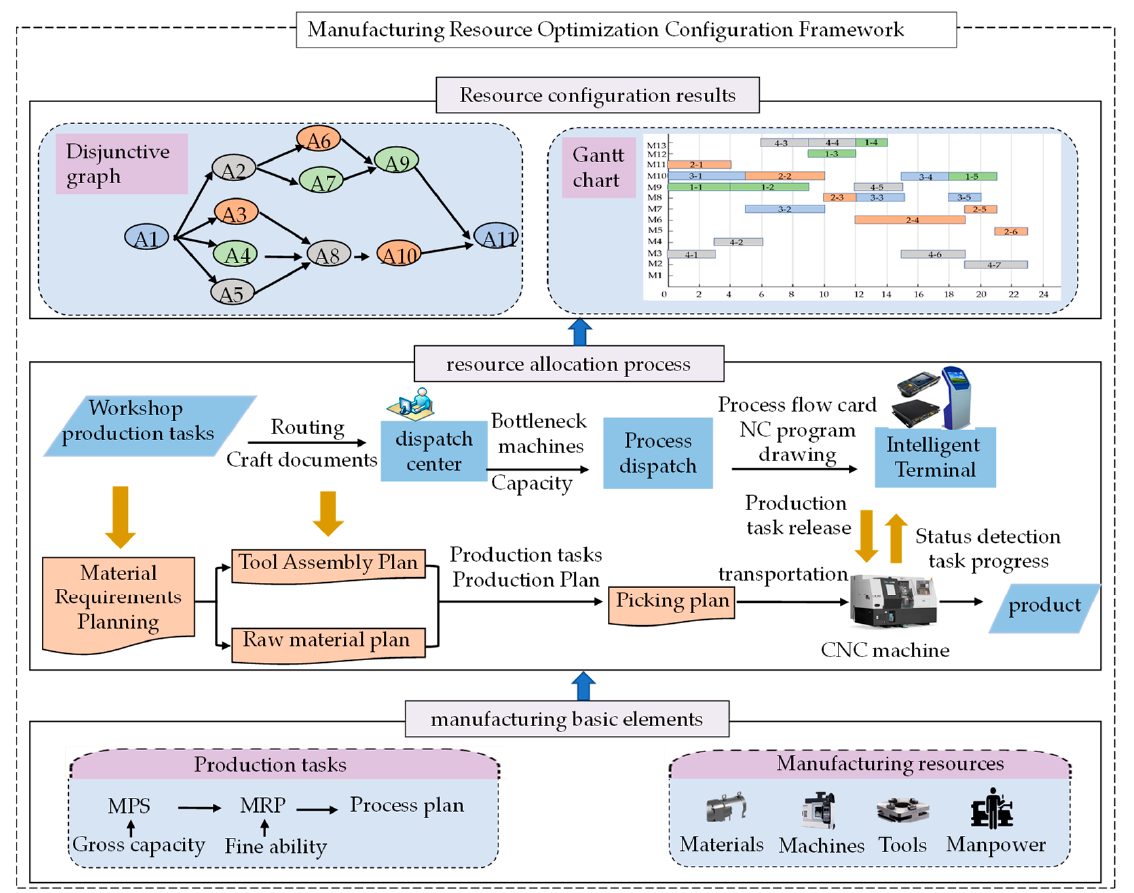
Figure 1. Flexible Workshop Resource Configuration Framework.